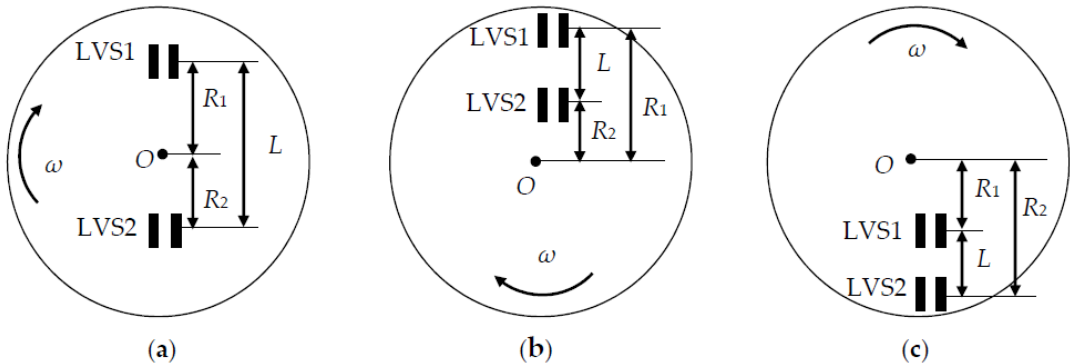
Figure 6. Locations of the rotational center O relative to the LVS1 and the LVS2: ( a ) O locates between LVS1 and LVS2; ( b ) O is below both LVS1 and LVS2; ( c ) O is above both LVS1 and LVS2.